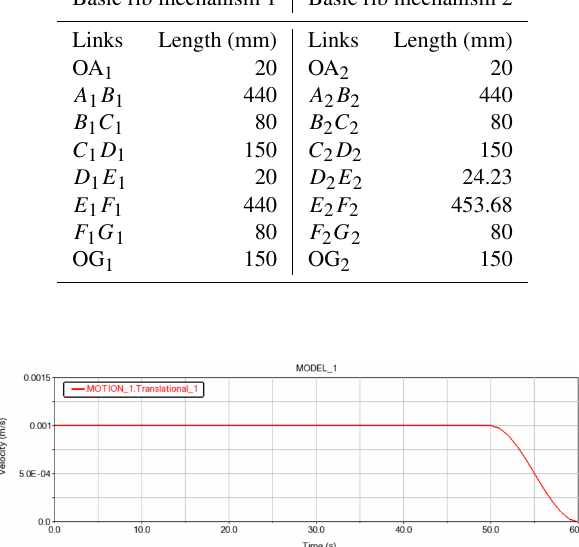
Figure 17. Speed curve of slider